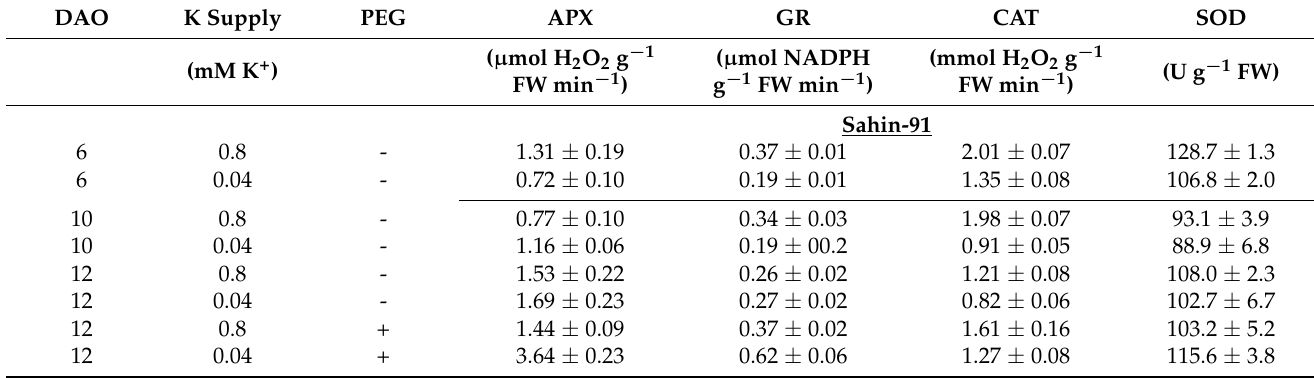
Table A1. Mean values ( ± SE) of antioxidant response (APX, GR, CAT and SOD) and ROS generation (H2O2 and O 2 − ) under two K-supply levels (0.04 and 8 mM K) and two PEG levels (no PEG: -,